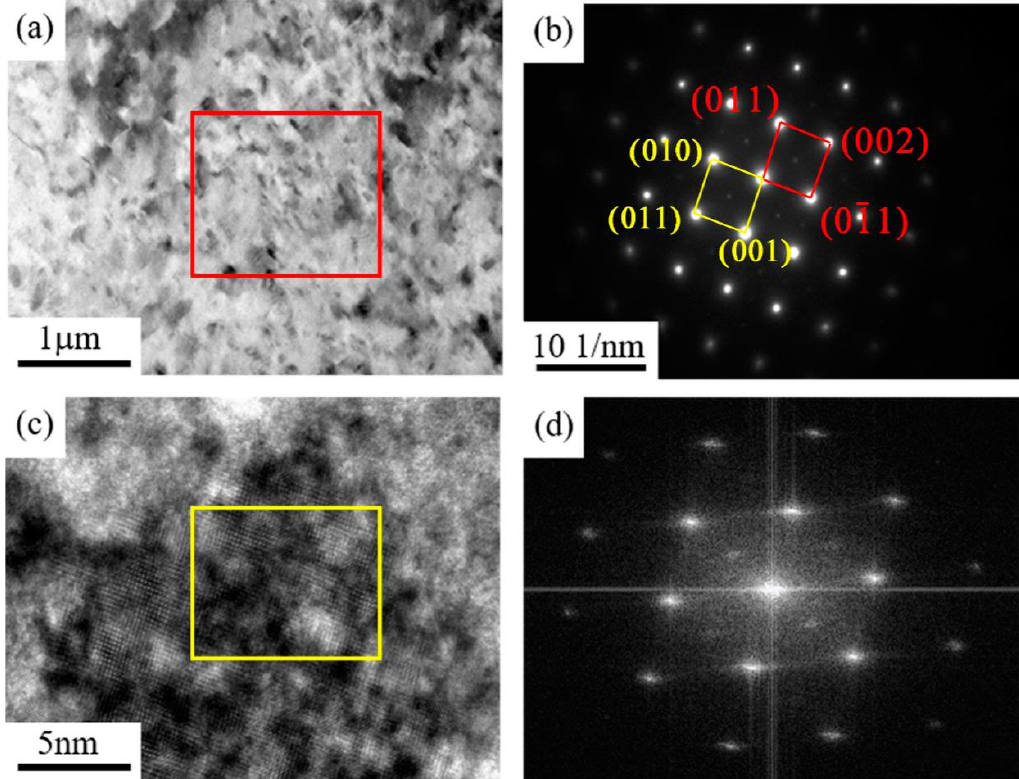
Figure 10. The microstructures of the as-annealed sample of the Cu–6Ni–6Sn–0.6Si alloy: ( a ) metallographic images, ( b ) SEM image, ( c ) TEM image, ( d ) EDS analysis.